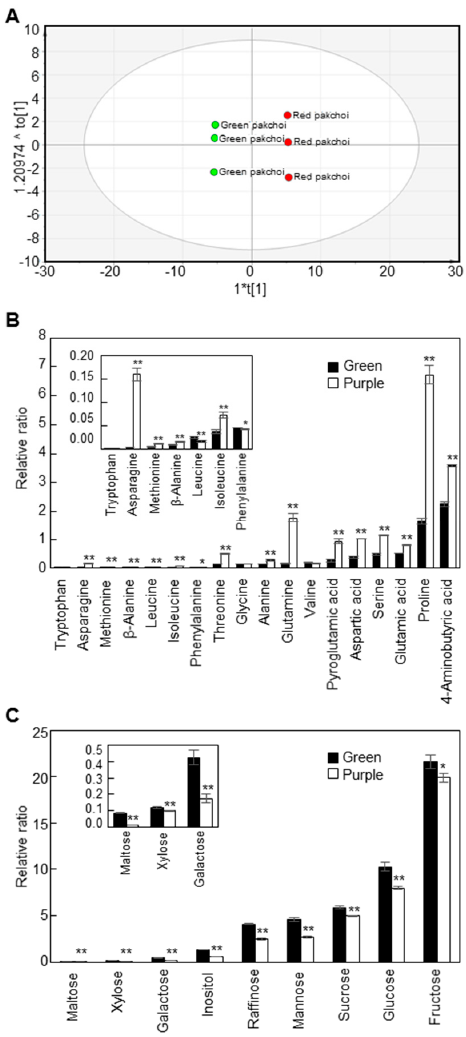
Figure 2. Metabolic profiling of two pakchoi cultivars. The OPLS-DA score plot ( A ), contents of amino acids and amino acid derivatives ( B ) and contents of sugars and sugar derivatives ( C ) in green and purple pakchoi. Contents of metabolites were measured in 2-month-old green and purple pakchoi ( µ g g − 1 dry weight). The quantitative calculations of all metabolites were based on the peak area ratios relative to that of the ribitol as an internal standard (IS). The peak area of metabolite was normalized to peak area of the IS, which the peak area ratio was used for the relative quantification. Each value represents the mean of three technical replicates and error bars are SDs. Asterisks indicate significant differences the purple pakchoi compared with the green pakchoi using Student’s t test (* p < 0.05; ** p < 0.01).